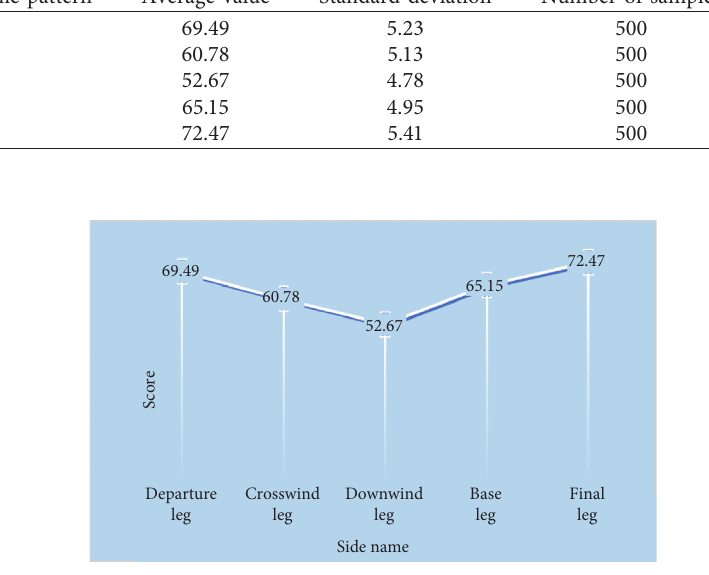
Figure 9: The scores of